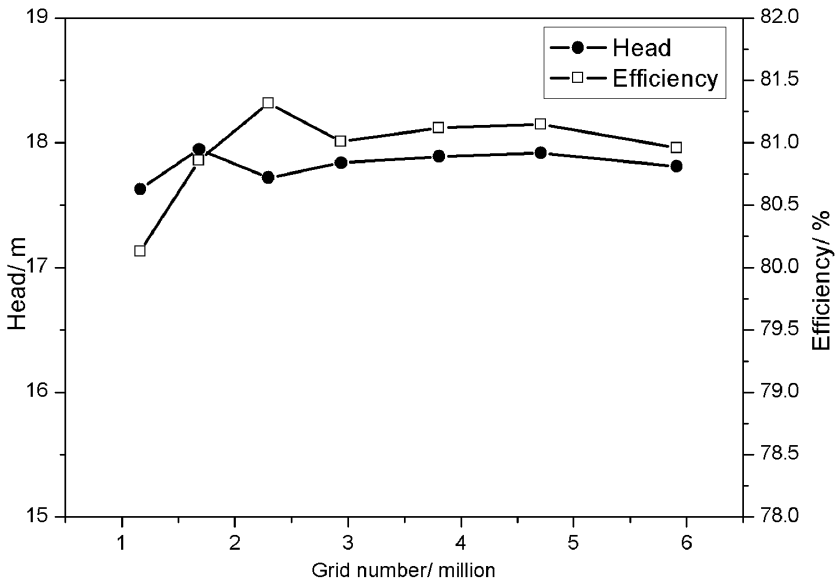
Figure 3. Predicted head values with different grid numbers.